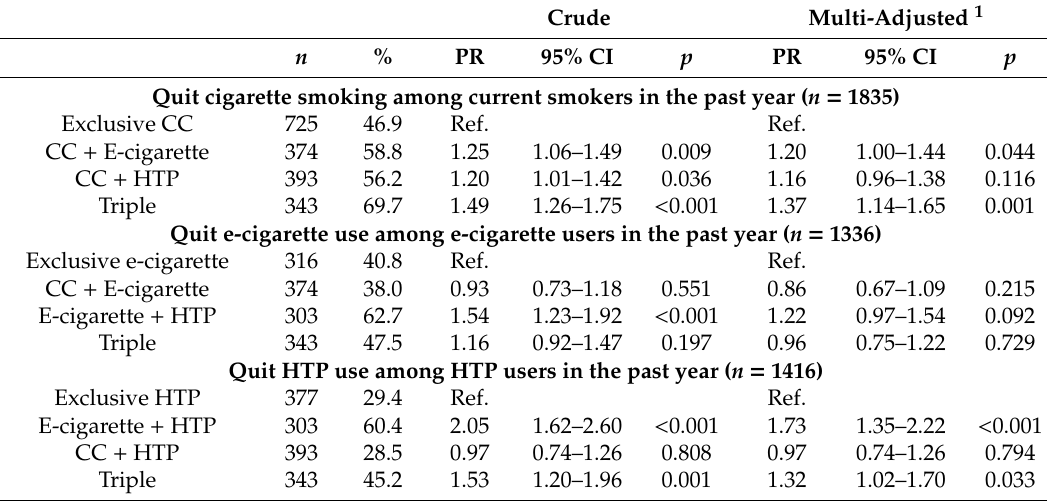
Table 3. Multivariate association between the type of tobacco products and related products use with quit attempts in the past